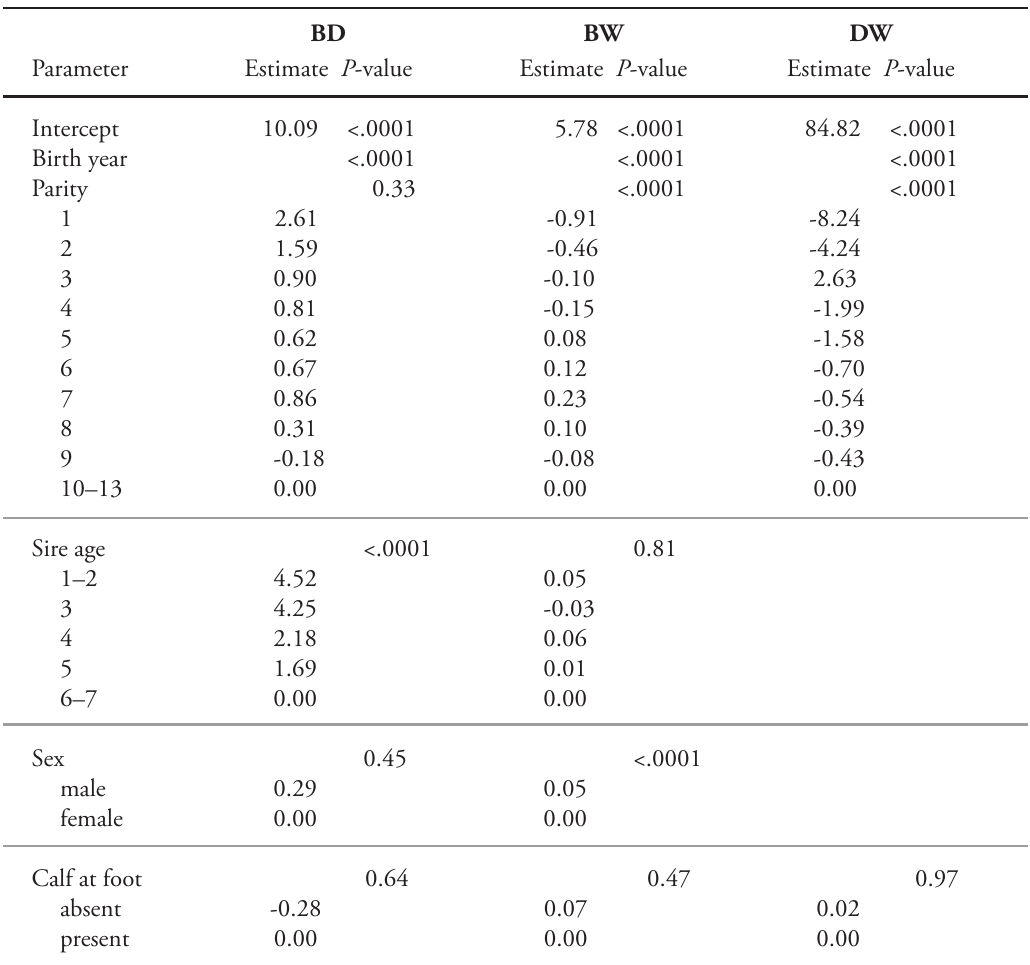
Table 2. The fixed effects for birth date (BD), birth weight (BW) and dam weight (DW) in the Kutuharju reindeer herd in 1987–2011. The level values of each factor are expressed as deviations from the last